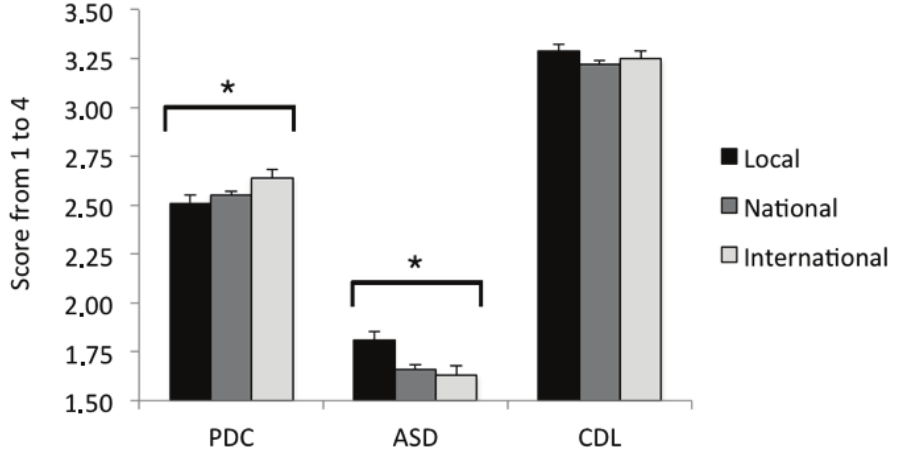
Figure 1. Perceived Decisional Competence (PDC), Anxiety and Strain to Decide (ASD) and Commitment in the Decisional Learning (CDL) based on the expertise level. Errors bars represent the standard error of the mean. * p < Table 1 MANCOVA multivariate contrasts F df error p η 2 Covariables Age 1.51 666 .195 .009 Years of experience 4.66 666 .001 .027 Independent variable Expertise level 2.82 1,334 .004 .017